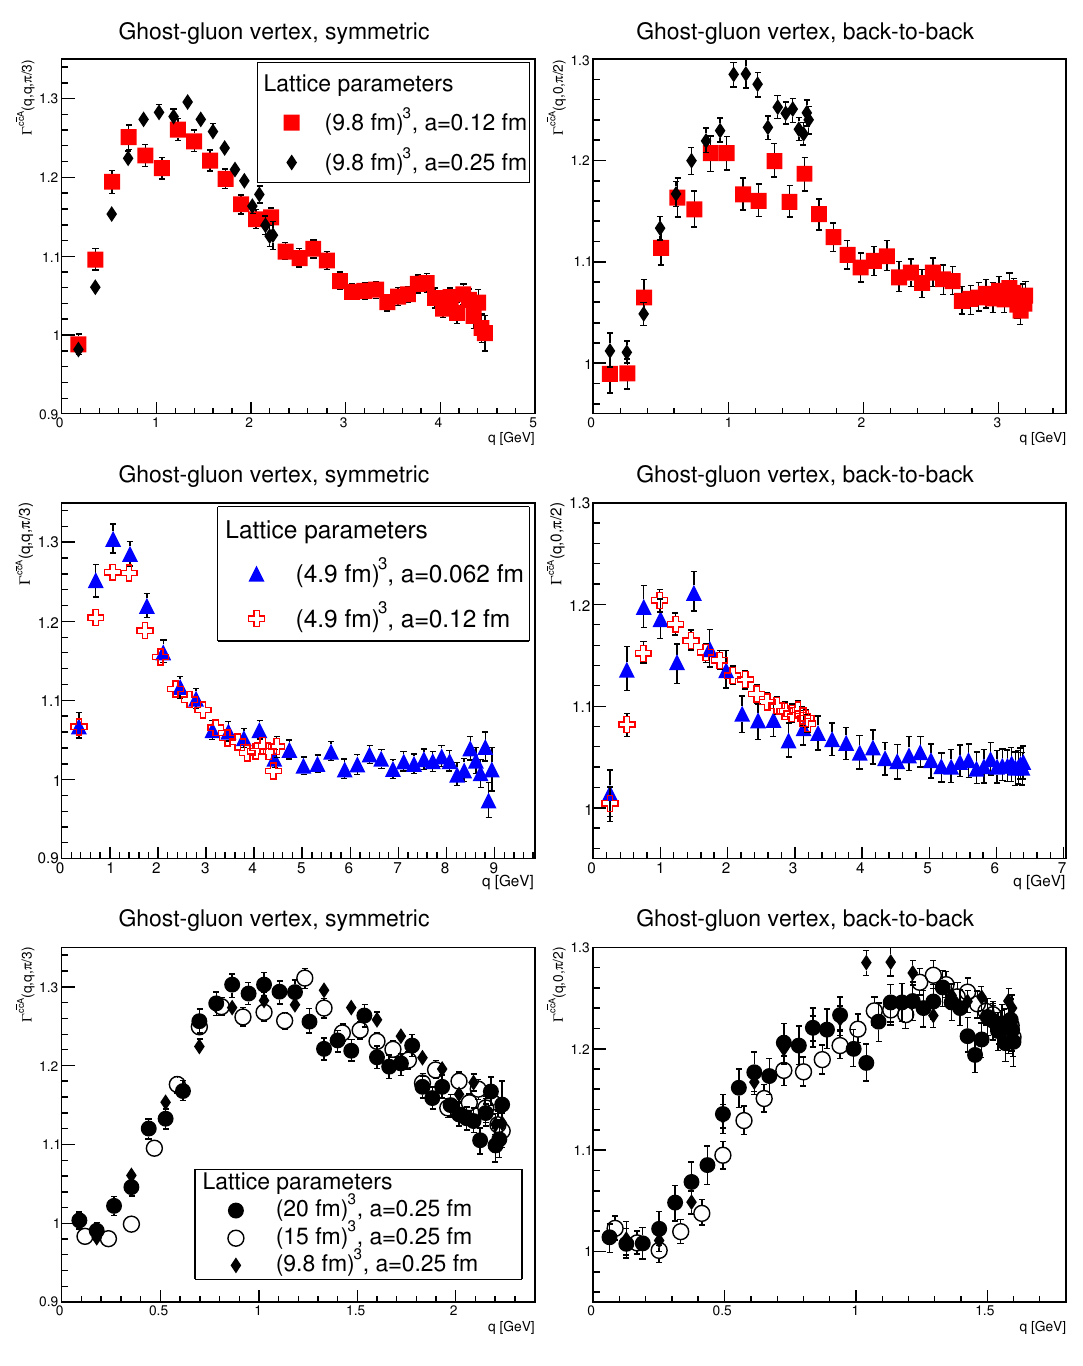
Figure 7: The systematic dependence on the lattice parameters for the ghost-gluon vertex in three dimensions. The left panels show the symmetric momentum configu- ration and the right panels the back-to-back momentum configuration. The top and middle panels show two cases with fixed physical volume and changing discretization and the bottom panel a case at fixed discretization and changing physical